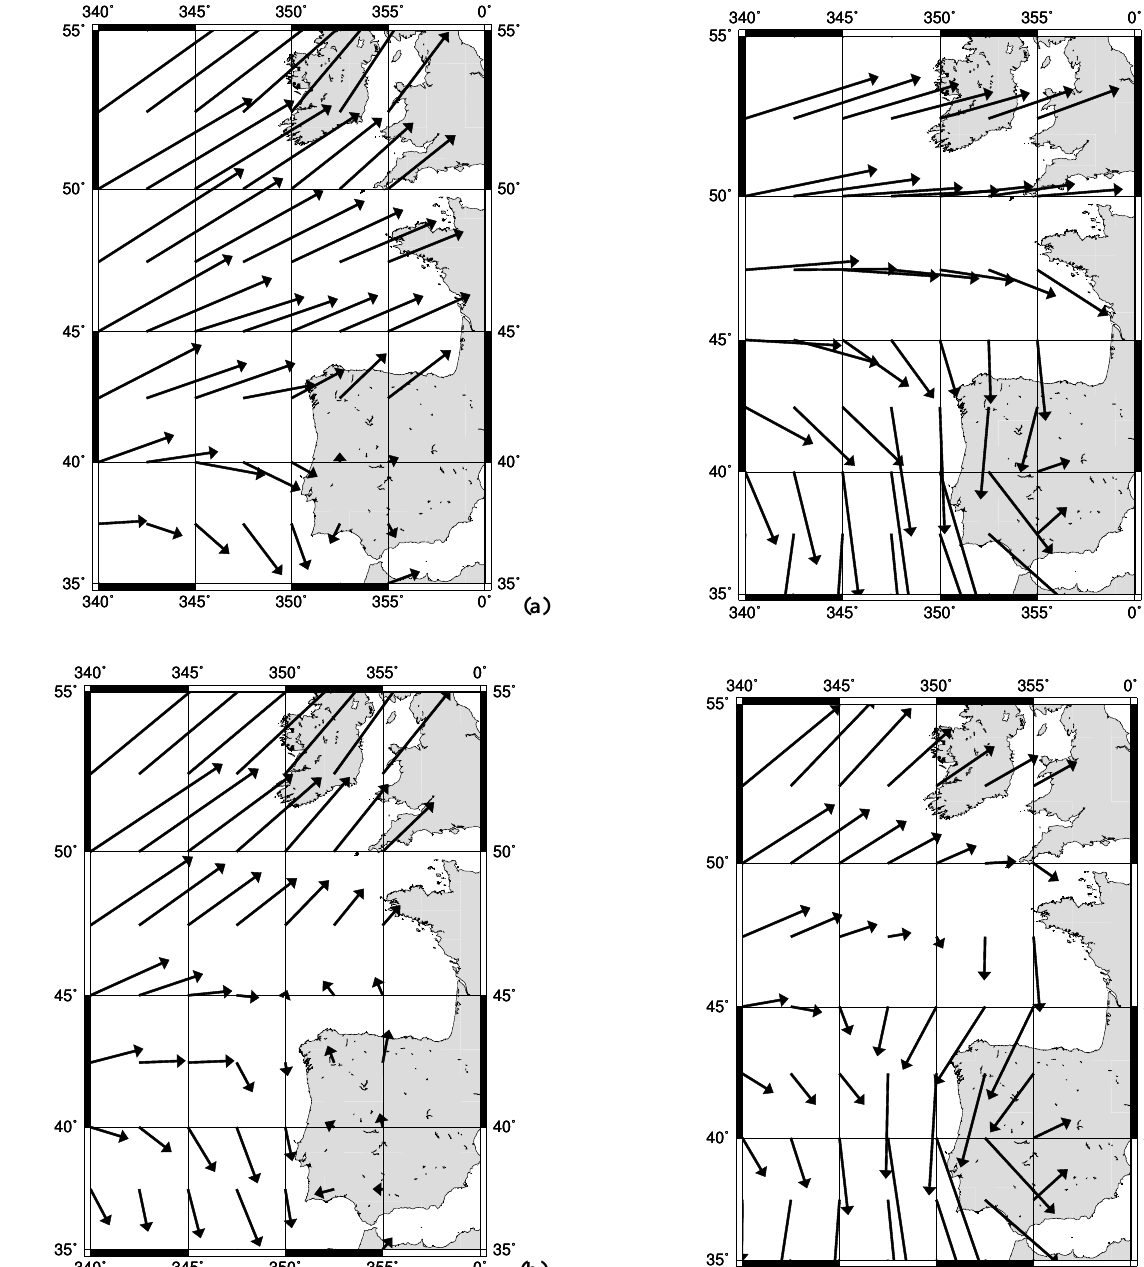
mainly by research vessels and ships of opportunity, since salinity data from remote sensing are not yet available (al- though salinity missions such as SMOS and AQUARIUS are being planned). Although drought is mainly characterised by unusually low rainfall, it is related to important atmo- spheric anomalies, such as winds, which also affect sea level. Seasonal time series of wind direction (azimuth) and magni- tude (speed) were computed from the surface zonal (u) and